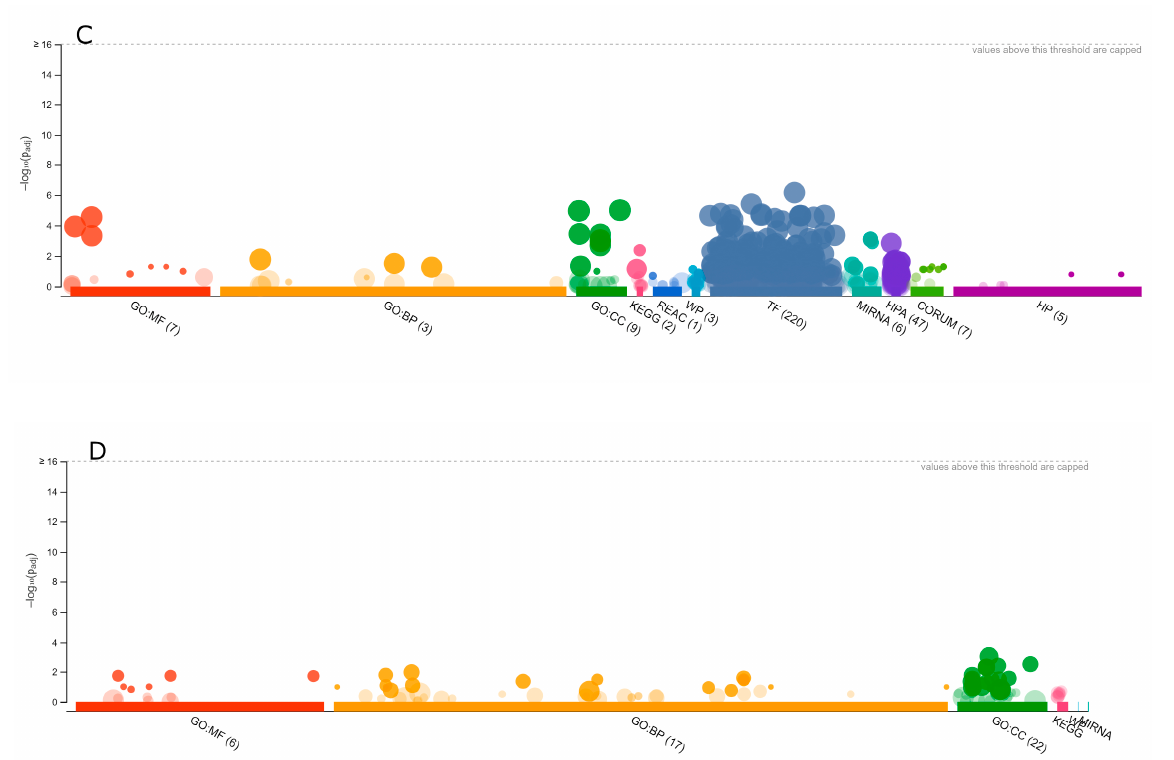
Figure 7. Grouping of eukaryotic genes. Manhattan plots of all H. sapiens ( A , C ) and A. thaliana ( B , D ) gene sets coding for ( A , B ) AFP 14–20 -like motif-containing and ( C , D ) GIP-9-like motif-containing proteins. The x -axis represents functional terms that are grouped and color-coded by data sources, while the y -axis shows the adjusted enrichment p -values in negative log10 scale. MF, molecular function; BP, biological process; CC, cellular component; KEGG, KEGG pathway; REAC, Reactome; WP, Wiki pathway; TF, transcription factor; MIRNA, microRNA; HPA, human Protein Atlas; CORUM, CORUM dataset; and HP, human phenotype. Each circle indicates the functional enrichment term, while the circle sizes correspond to the term size; larger terms have larger